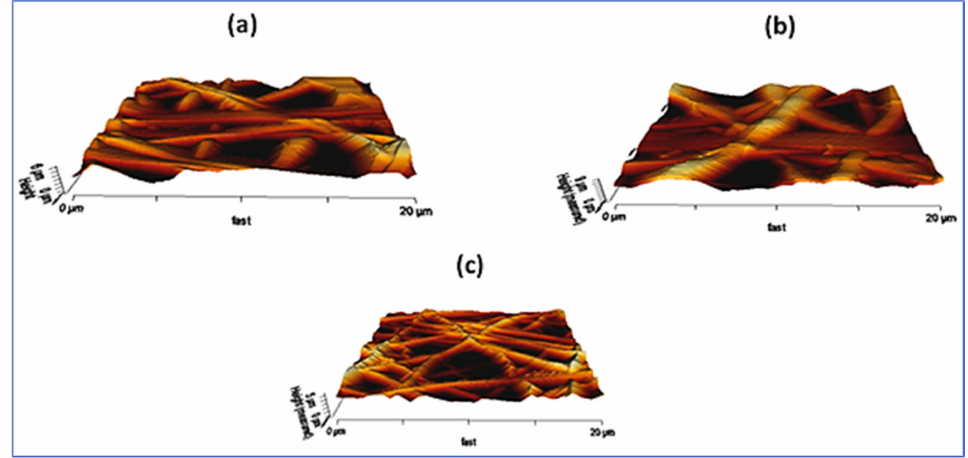
Figure 10. AFM images of ( a ) PU, ( b ) PU/PM, and ( c ) PU/PM/CuSO 4. Reproduced from Ref.